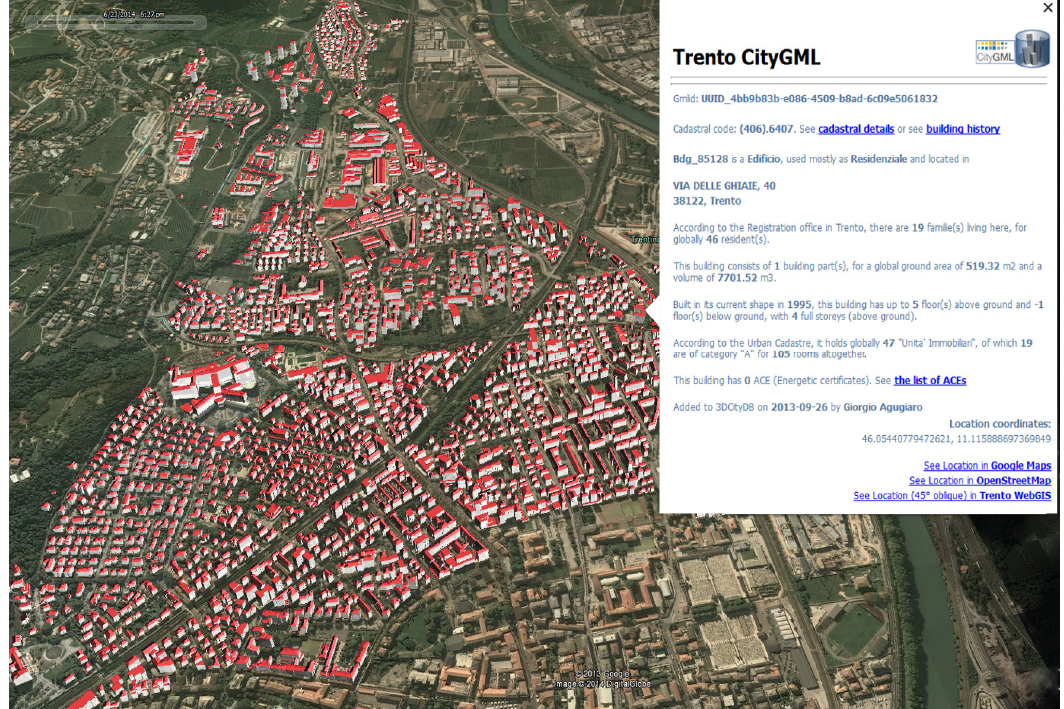
Figure 8 Visualisation in Google Earth of the 3D virtual city model of the study area in Trento. The main attributes for each building can be accessed by means of balloons. Balloons contain also hyperlinks to external data sources (see next Figure